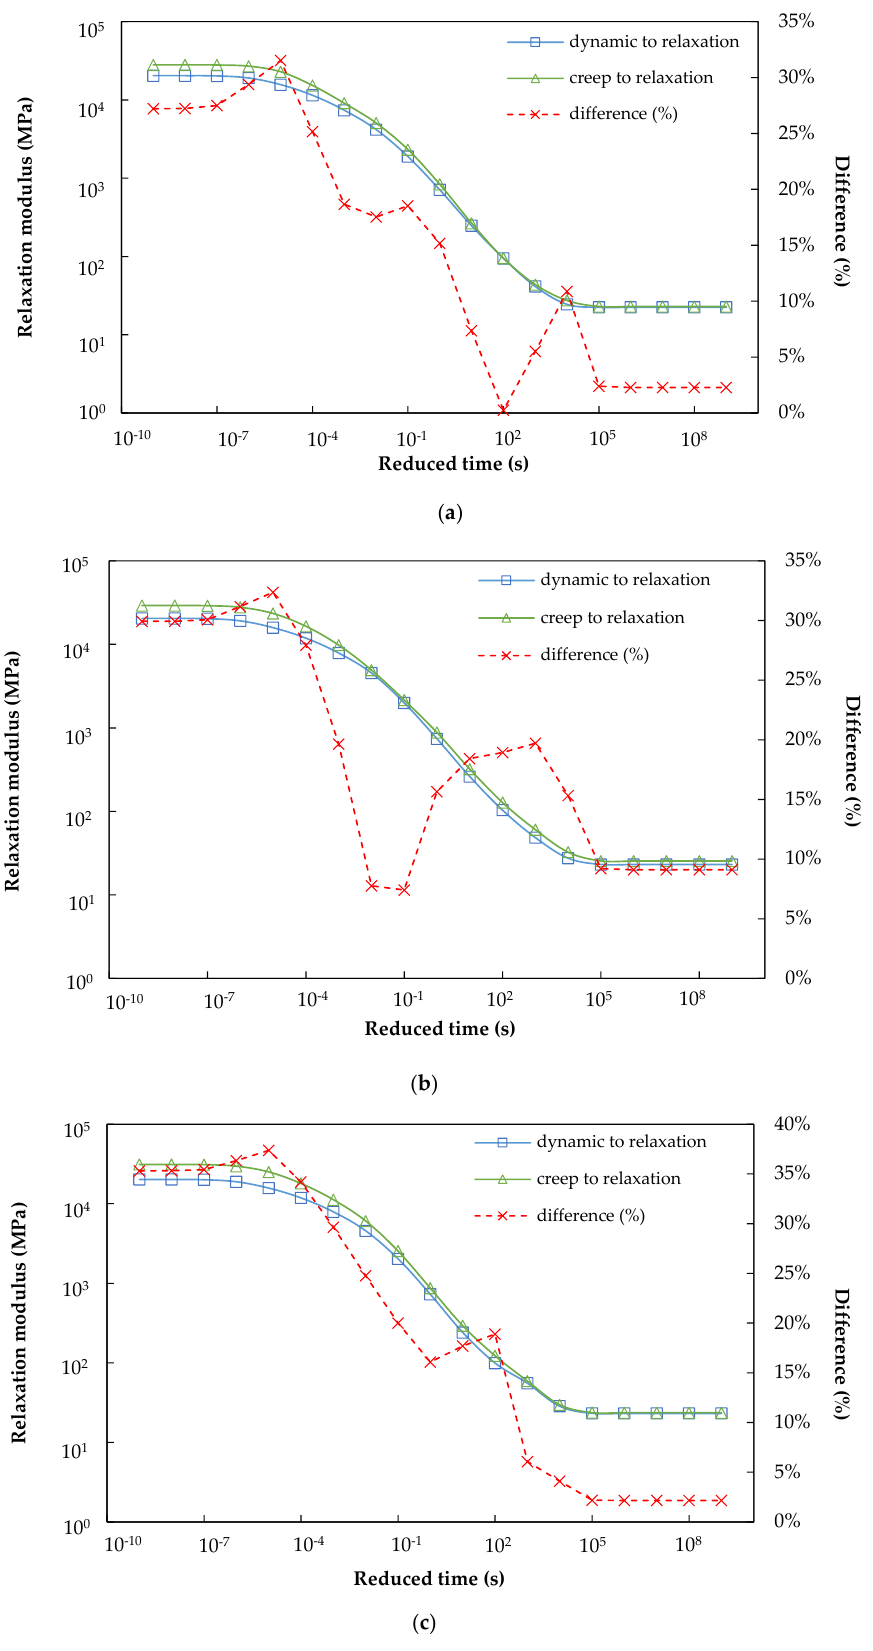
Figure 6. Relaxation modulus master curve converted from dynamic modulus and creep compliance in log-log scale for ( a ) Evotherm; ( b ) Rubber; ( c ) Polymer.